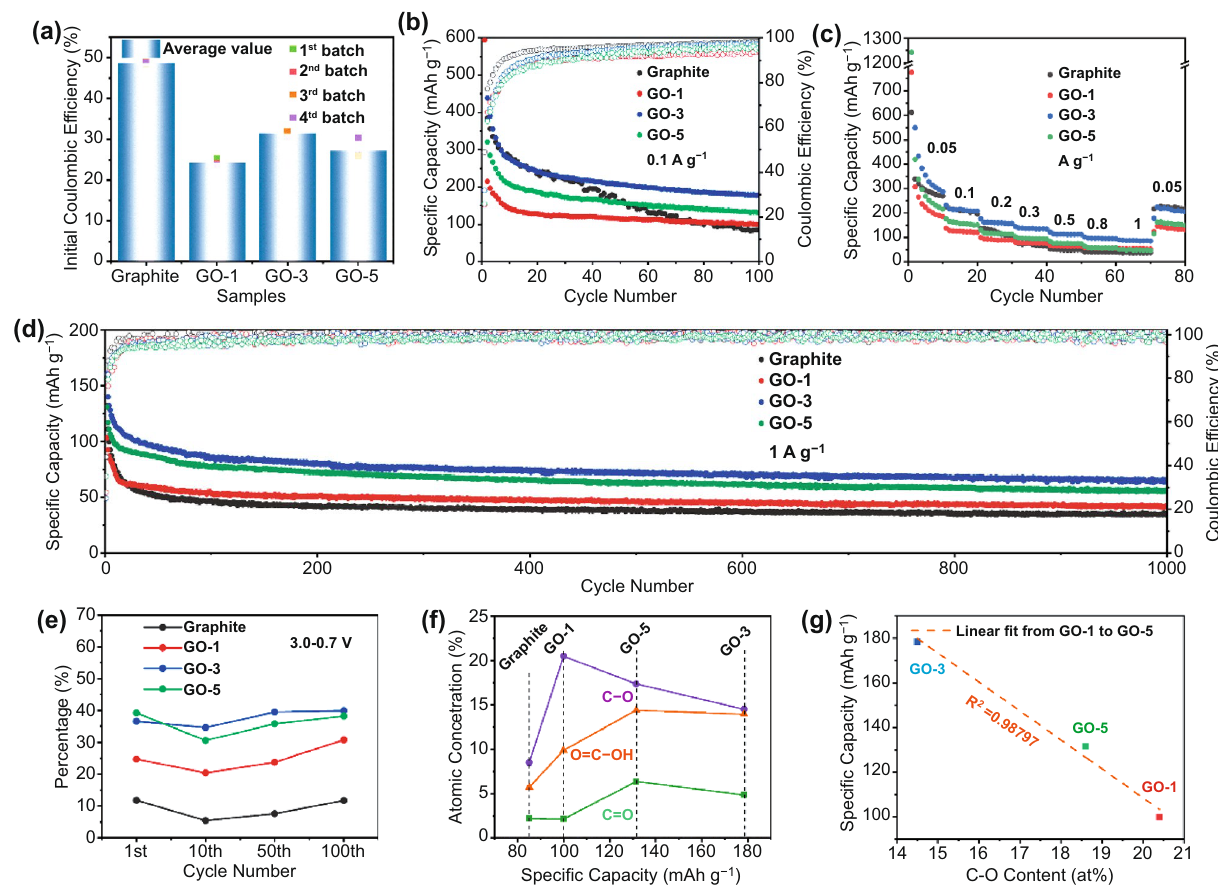
Fig. 2 Electrochemical properties of graphite and GO samples. a Initial Coulombic efficiency. b Cycling performance at 0.1 A g −1 . c Rate per- formance. d Long-term cycling performance at 1 A g −1 . e Percentage of discharge capacity delivered in the voltage range of 3.0–0.7 V. f Rela- tionship between atomic concentration of various oxygen functional groups obtained from O 1s XPS spectra (Fig. 2 h) and reversible specific capacity after 100 cycles at 0.1 A g −1 . g Relationship between reversible specific capacity and C-O